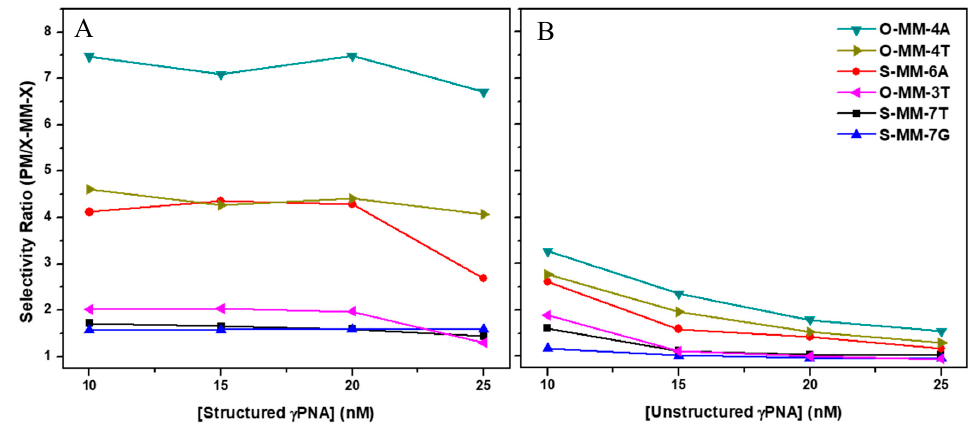
Figure 3. Selectivity ratio of ( A ) struc_ γ PNA and ( B ) unstruc_ γ PNA as determined by dividing the association max (max response units (RU) in Figures 1 and 2) of the perfect match to each respective target mutant association max.